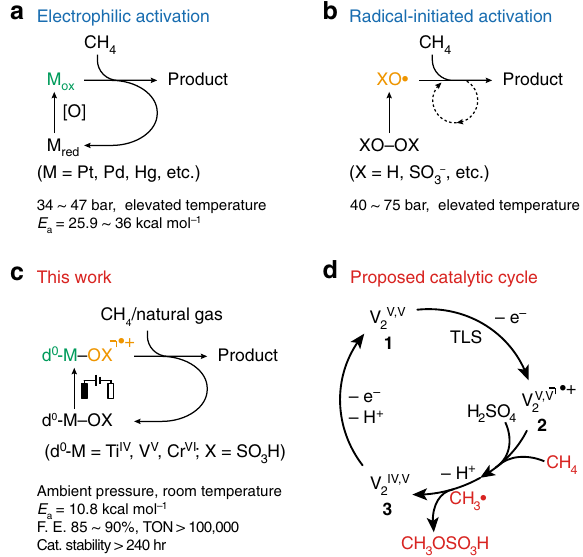
Fig. 1 Pathways to CH 4 functionalization. a – c Representative approaches of CH 4 functionalization based on electrophilic activation 3 – 6 ( a ) and radical chain mechanism 8 – 10 ( b ), in comparison with the proposed electrocatalytic method ( c ). d The proposed catalytic cycle of electrocatalytic CH 4 activation with d 0 vanadium (V)-oxo dimer ( 1 ). M red and M ox , reduced and oxidized metal active sites, respectively; [O], chemical or electrochemical oxidation; E a , activation energy; d 0 – M, d 0 early transition metal species; F.E. Faradaic ef fi ciency, TON turnover number, TLS turnover-limiting